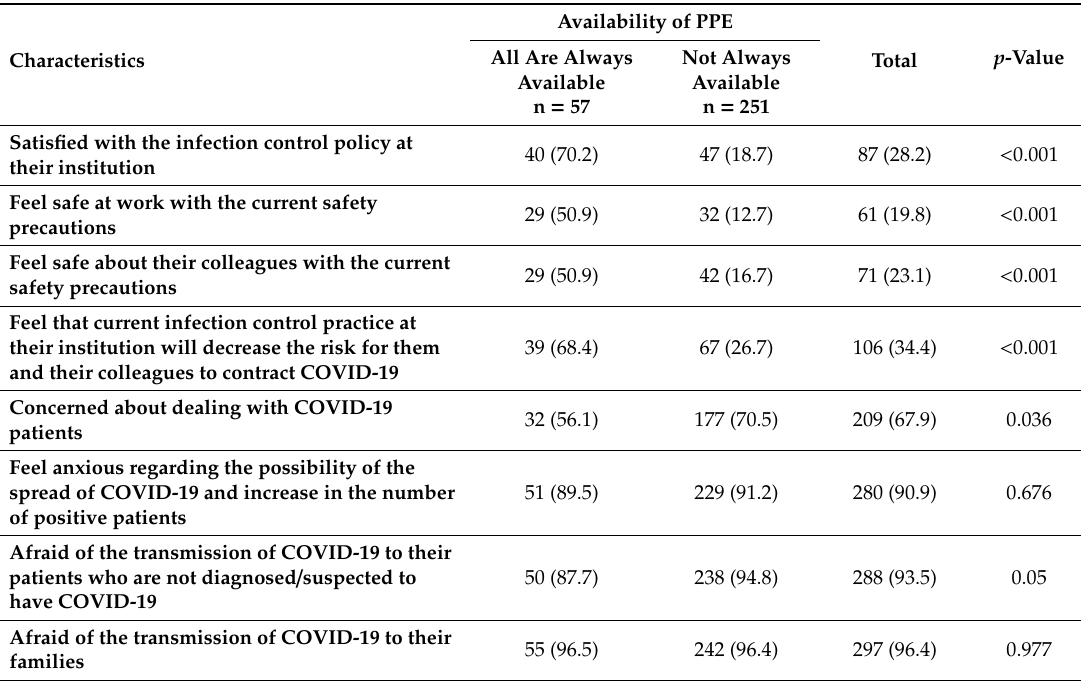
Table 6. The influence of the availability of PPE on the psychological interactions and preparedness of frontline Jordanian